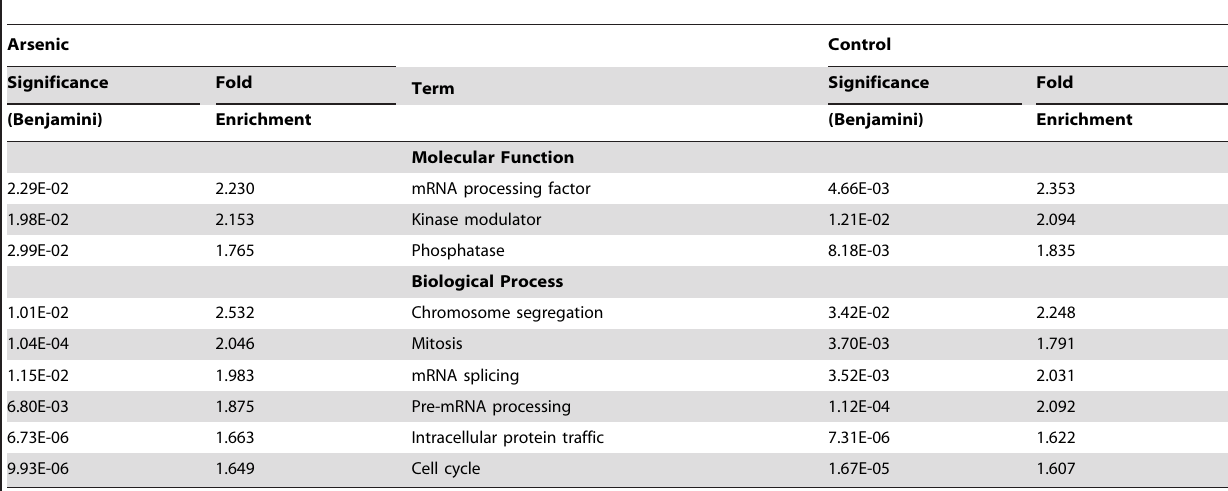
Table 2. Functional annotation clusters in common between gene lists from arsenic and control